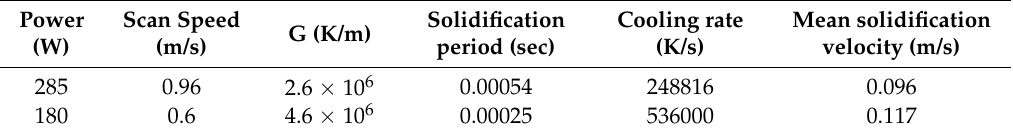
Table 1. Laser track welding parameters used in the